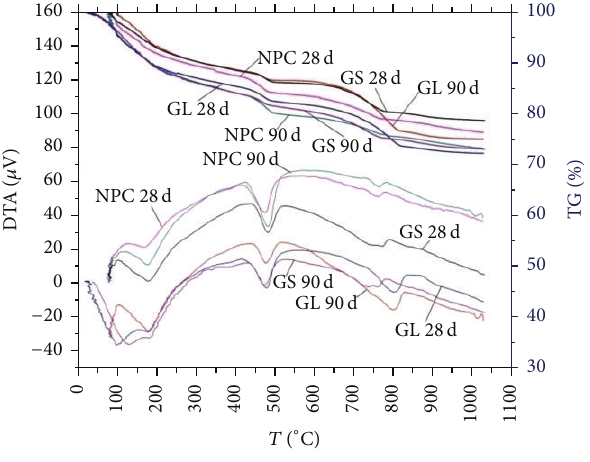
Figure 4: TG-DTA curves of samples.